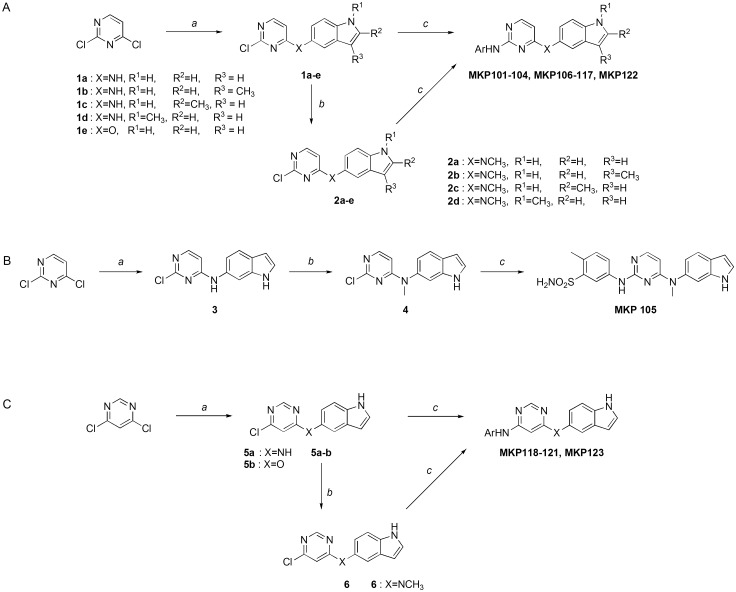
Synthesis of MKP101-123.Reagents and conditions: (A) Synthesis of MKP101-104, MKP106-117, MKP122: (a) 5-Aminoindoles (0.8–1.0 equiv.), Et3N (0.8–3.0 equiv.), isopropanol, rt, 1–10 h, or 5-hydroxyindole (0.77 equiv.), DBU (1.54 equiv.), MeCN, rt, 1 h; (b) CH3I (1.0–1.5 equiv.), NaH (or Cs2CO3) (1.0–1.2 equiv.), DMF, 0°C (or rt), 1 h; (c) ArNH2 (0.9–1.1 equiv.), 1-butanol, microwave irradiation, 200°C, 30 min. (B) Synthesis of MKP105: (a) 6-Aminoindole (1.5 equiv.), MeOH / H2O (1:3), rt, overnight; (b). CH3I (1.0 equiv.), NaH (1.0 equiv.), DMF, -10°C, 2h; (c) 5-Amino-2-methylbenzenesulfonamide (0.9–1.1 equiv.), 1-butanol, microwave 200°C, 30min. (C) Synthesis of MKP118-121, MKP123: (a) 5-Aminoindole (1.0 equiv.), Et3N (1.0 equiv.), isopropanol, rt, 2 h or 5-hydroxyindole (1.2 equiv.), DBU (2.0 equiv.), MeCN, rt, 1 h; (b) CH3I (1.1 equiv.), NaH (1.1 equiv.), DMF, 0°C rt, 1h; (c) ArNH2 (0.9–1.1 equiv.), 1-butanol, microwave irradiation 200°C, 30 min.